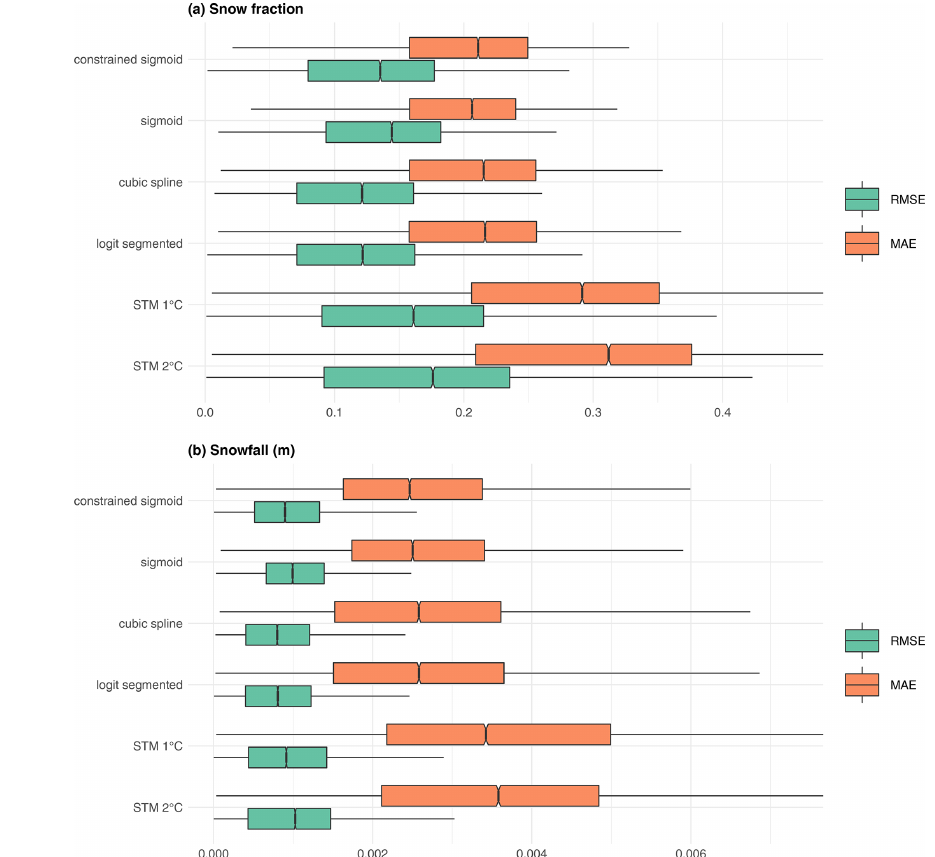
Figure 3. Forecasting performance of the five considered methods applied to ERA5 reanalysis in terms of mean absolute error (orange) and root mean squared error (green). (a) Snow fraction. (b) Snowfall